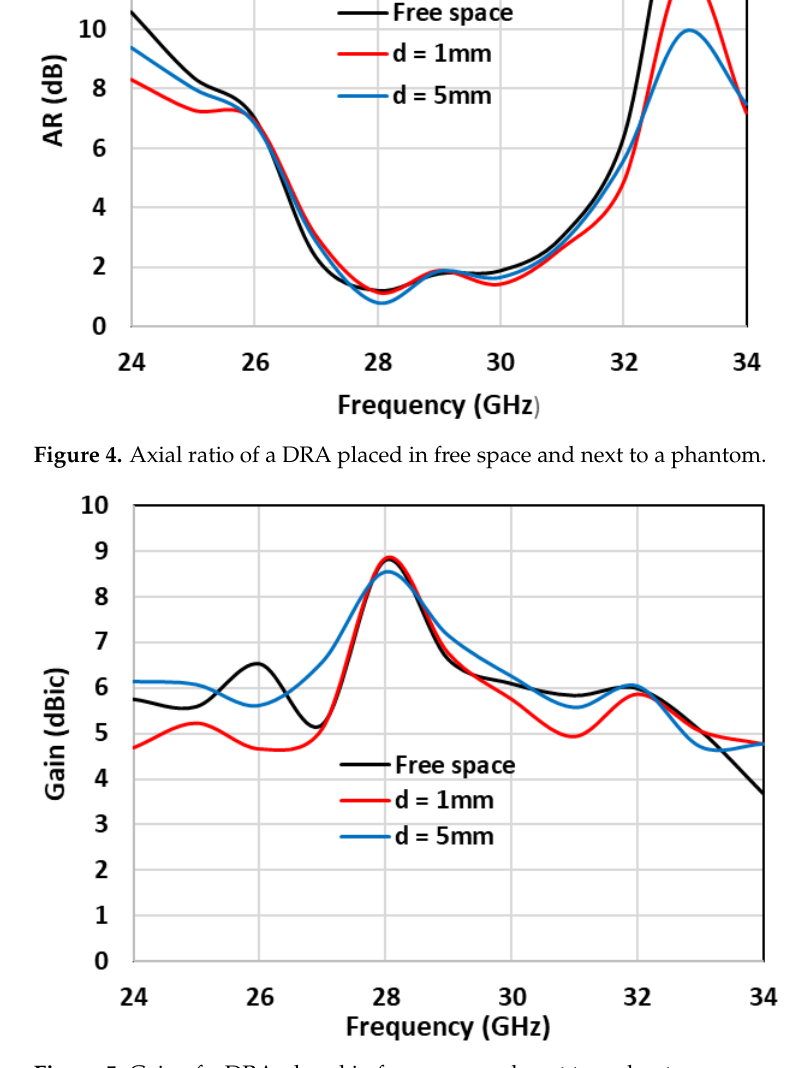
Figure 5. Gain of a DRA placed in free space and next to a phantom.